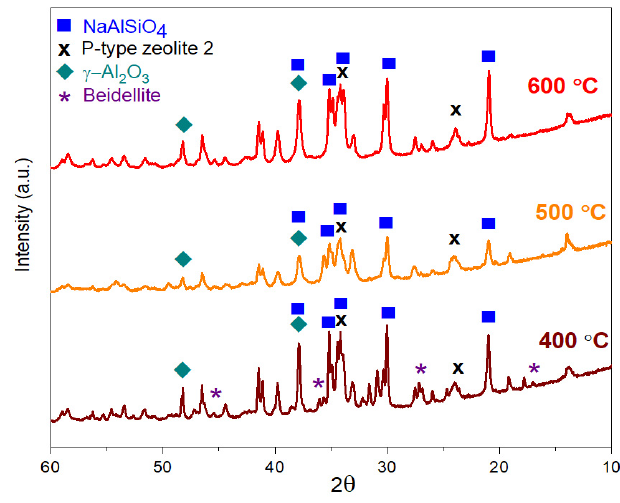
Figure 6. X-ray powder diffraction spectra of samples containing 33% red mud heat-treated at 400 °C, 500 °C, and 600 °C.